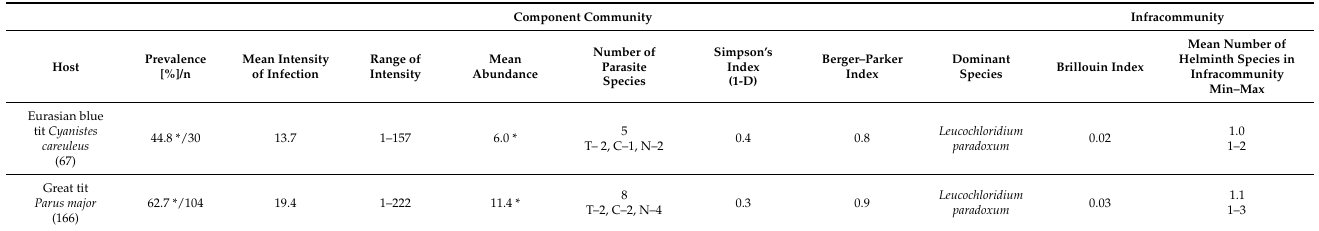
Table 2. Structure of helminth communities of Eurasian blue tit and Great tit during autumn migration on the southern coast of the Baltic Sea, northern Poland, 2008–2012. Numbers of examined birds are given in brackets.